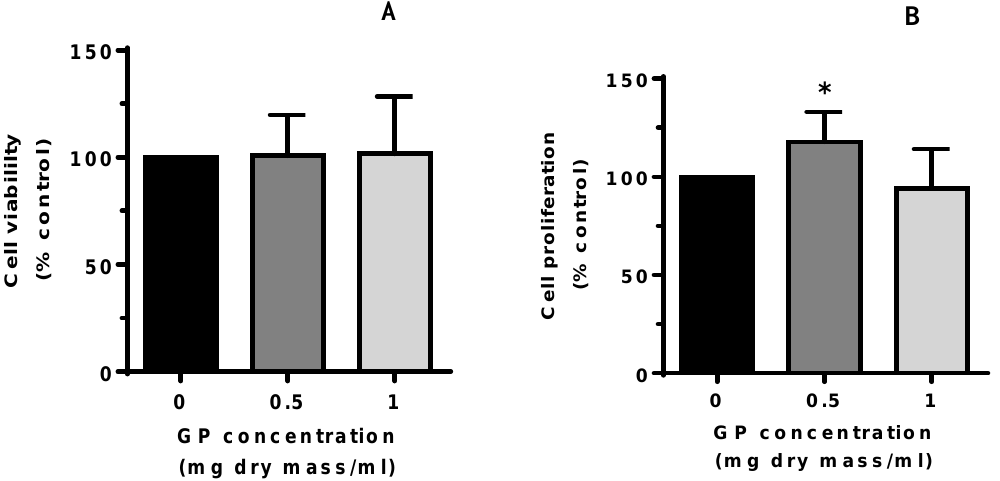
Figure 2. Effect of the G. parviflora extract (GP) on endothelial cell viability ( A ) and proliferation ( B ). Cells were treated with the GP extract or vehicle control for 24 h and was then assessed for viability (Trypan blue exclusion test) and proliferation (MTT test). The data were derived from three independent experiments. The data expressed as mean ± SD. Asterisks represent a significant difference compared to control cells (* p <